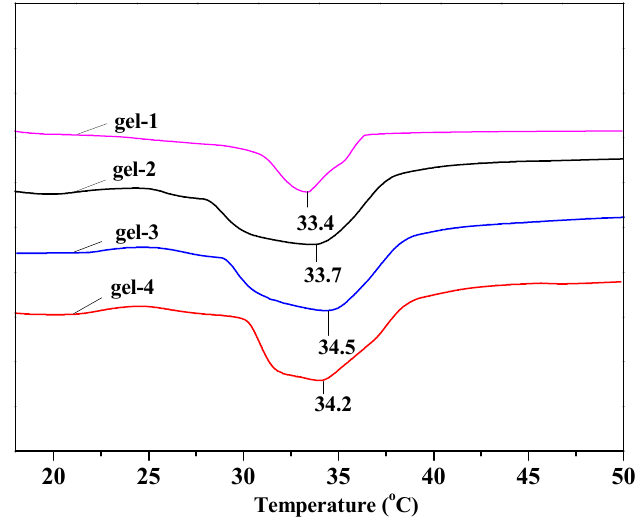
Figure 5. Differential scanning calorimetry (DSC) curves of hydrogels.